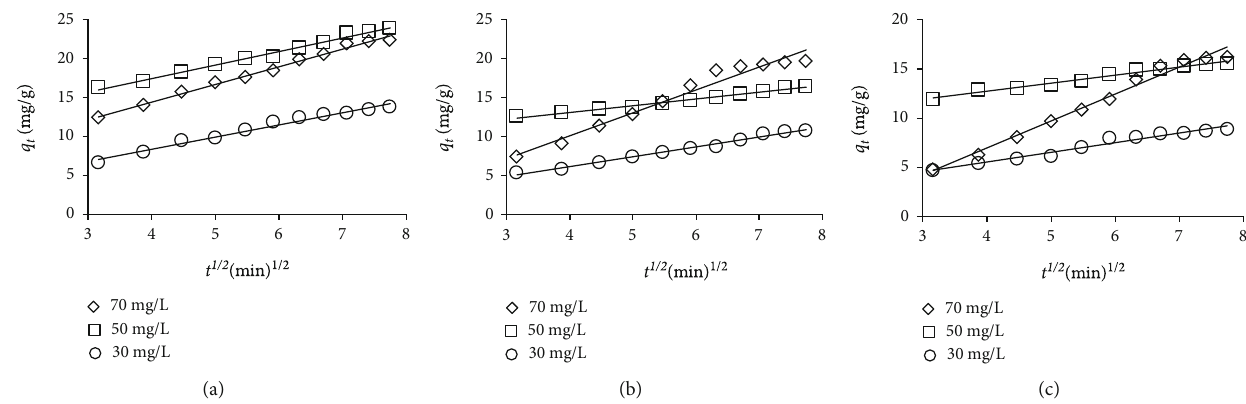
Figure 16: Intraparticle di ff usion kinetic plot for adsorption of (a) Pb (II), (b) Cr (III), and (c) Cd (II) on amidoxime chelating resin for di ff erent initial feed concentrations at pH5 and temperature at 25 ° C. Table 2: Langmuir and Freundlich isotherm constants for lead (II), Cr (III), and Cd (II) adsorption on amidoxime chelating resin. Langmuir isotherm constants Freundlich isotherm constants Compounds T (k) q